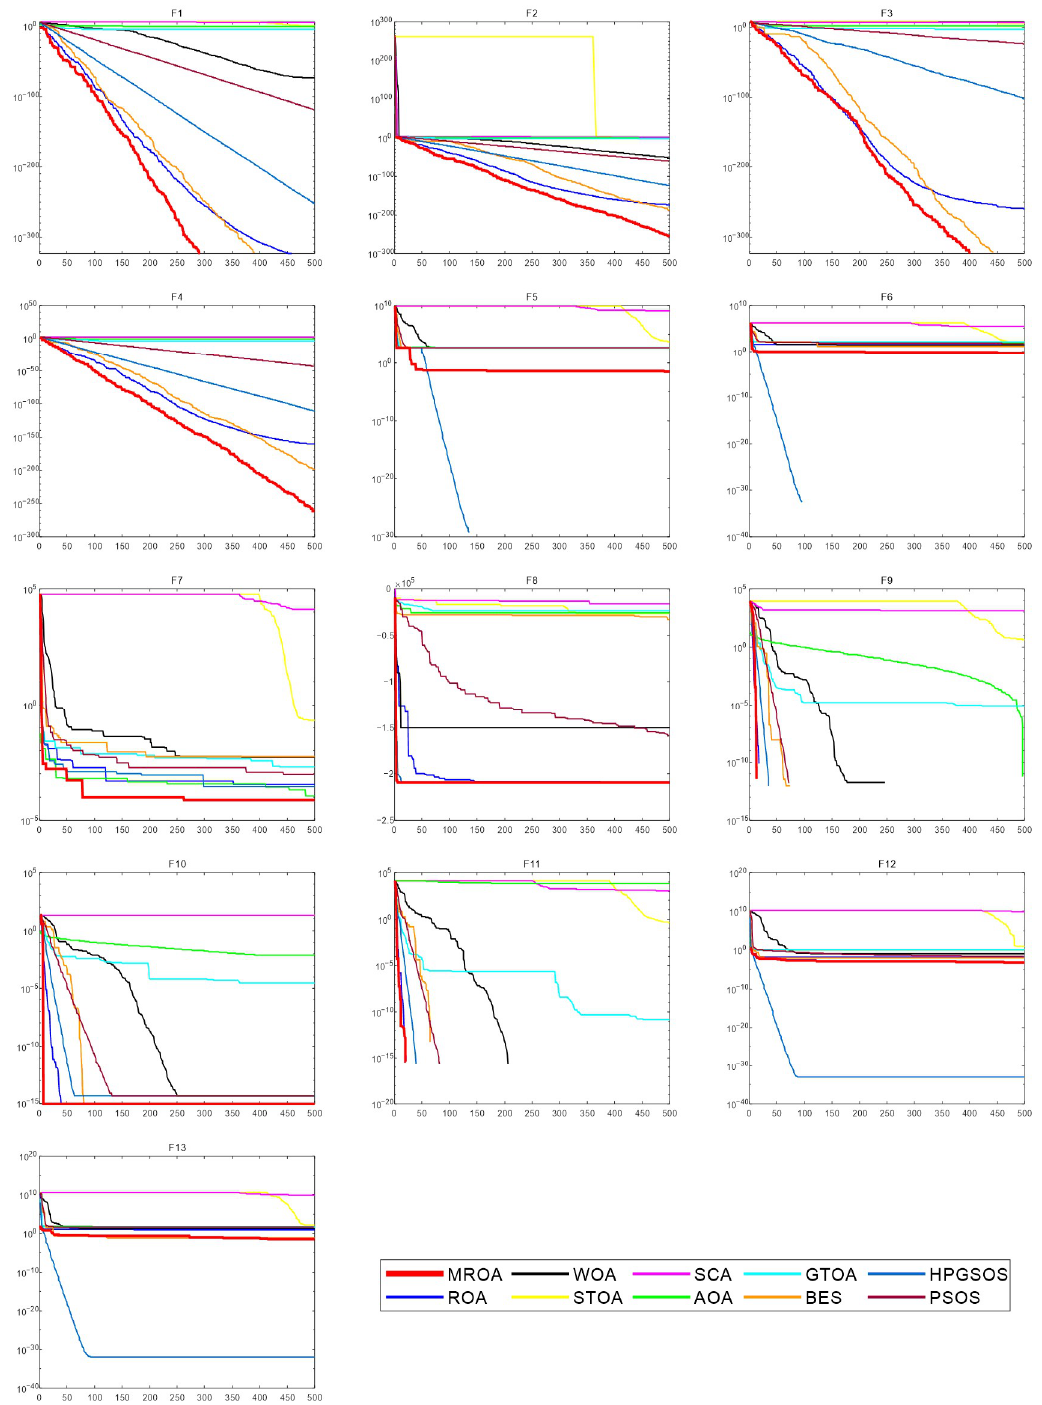
Figure 7. The convergence curves for the optimization algorithms on test functions (F1–F13) with dim = 500.